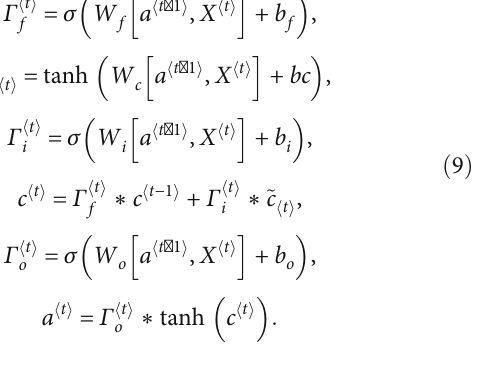
ffiffiffiffiffiffiffiffiffiffiffiffiffiffiffiffiffiffiffiffiffiffiffiffiffiffi 1/ n